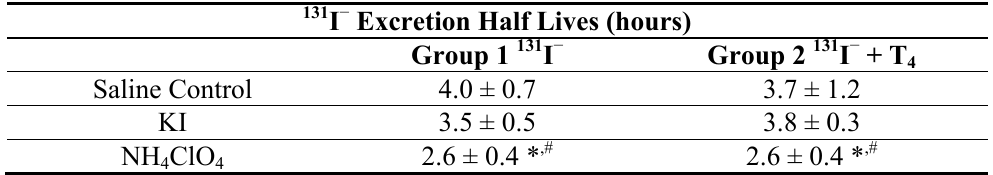
Table 2. Twenty four hour urinary excretion half-lives for 131 I − for Group 1 and 2